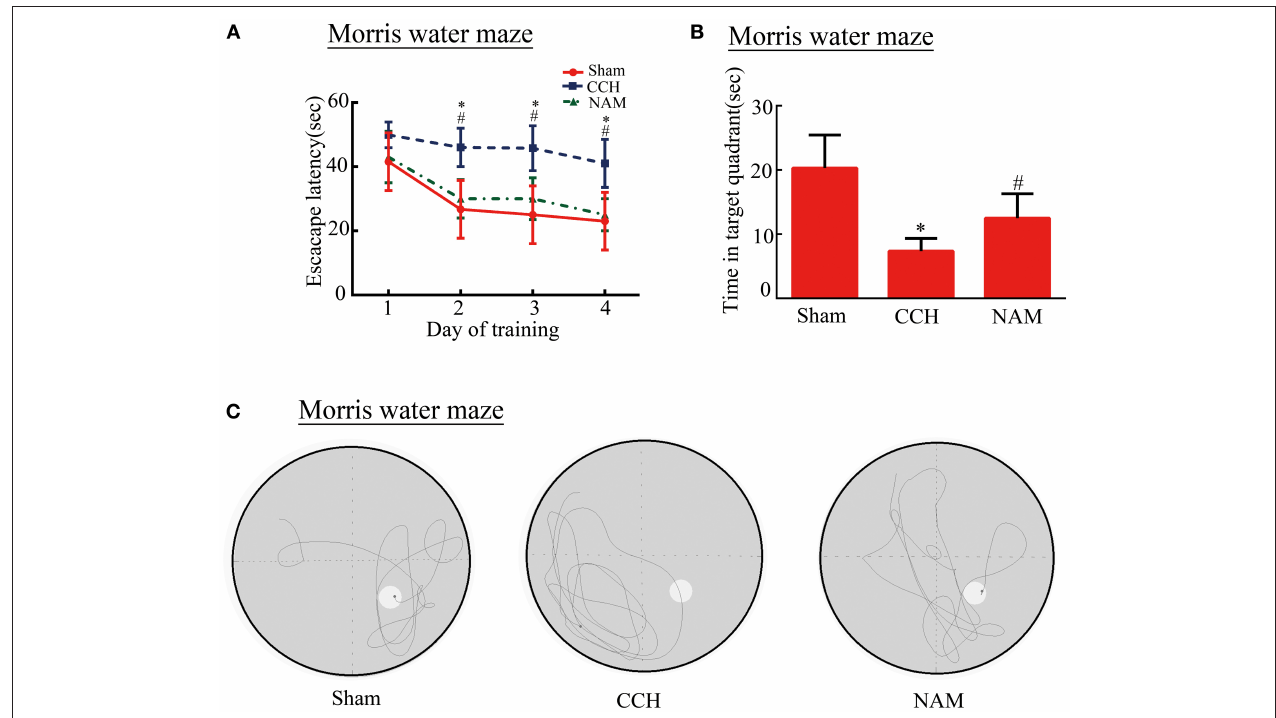
FIGURE 2 | Effect of NAM on mouse cognitive function ( n = 8/group). (A) : Escape latency of mice; (B) : Time spent in target quadrant; and (C) : The recorded swim trajectories of three groups in probe trial of MWMT. * p < 0.05, compared with sham group; # p < 0.05, compared with CCH